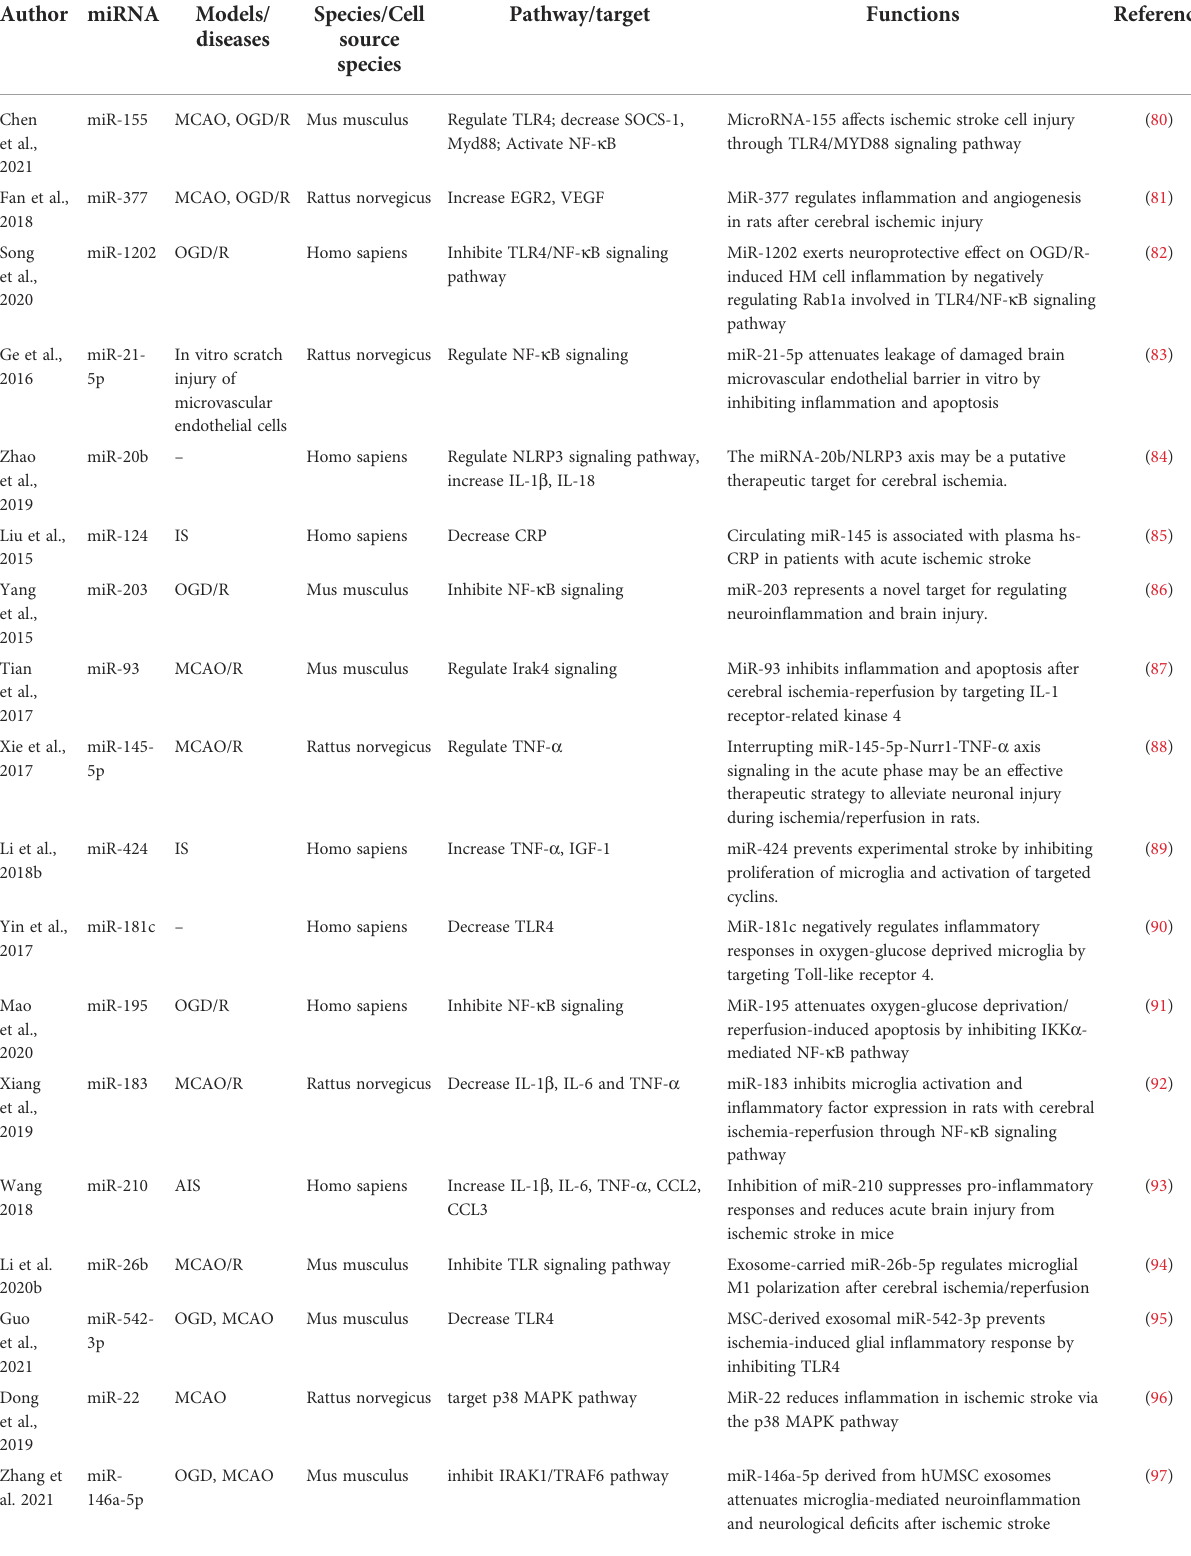
TABLE 4 The summary of the mechanisms of miRNAs in cerebral